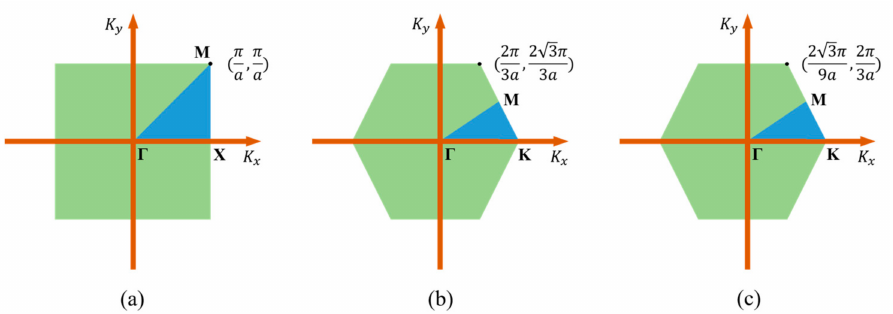
Figure 2. Three kinds of crystal lattices of the first Brillouin zone in reciprocal space for: ( a ) square lattice and square hollow cylinder lattice, ( b ) honeycomb lattice, ( c ) triangular